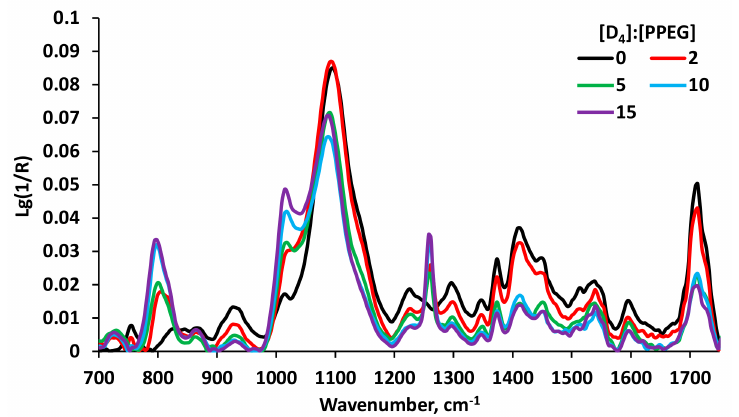
Figure 9. FTIR spectra of polymers based on [PPEG]:[D 4 ]:[TDI] = 1:X:8.